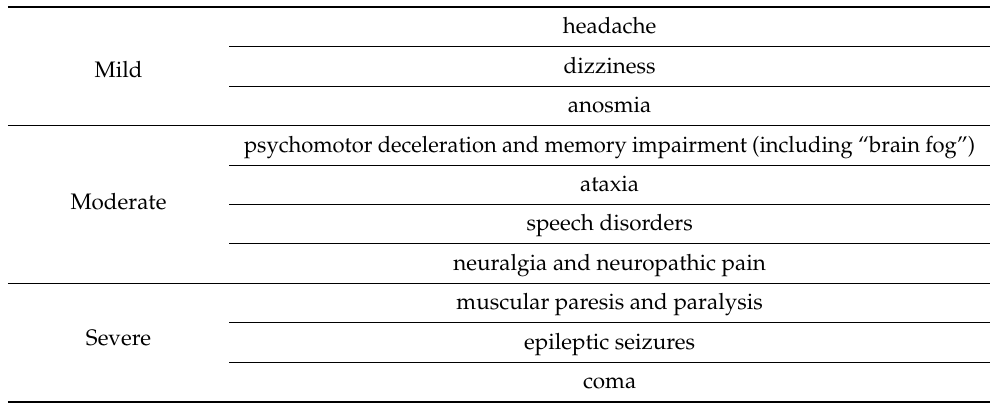
Table 1. Neurological symptoms in patients with